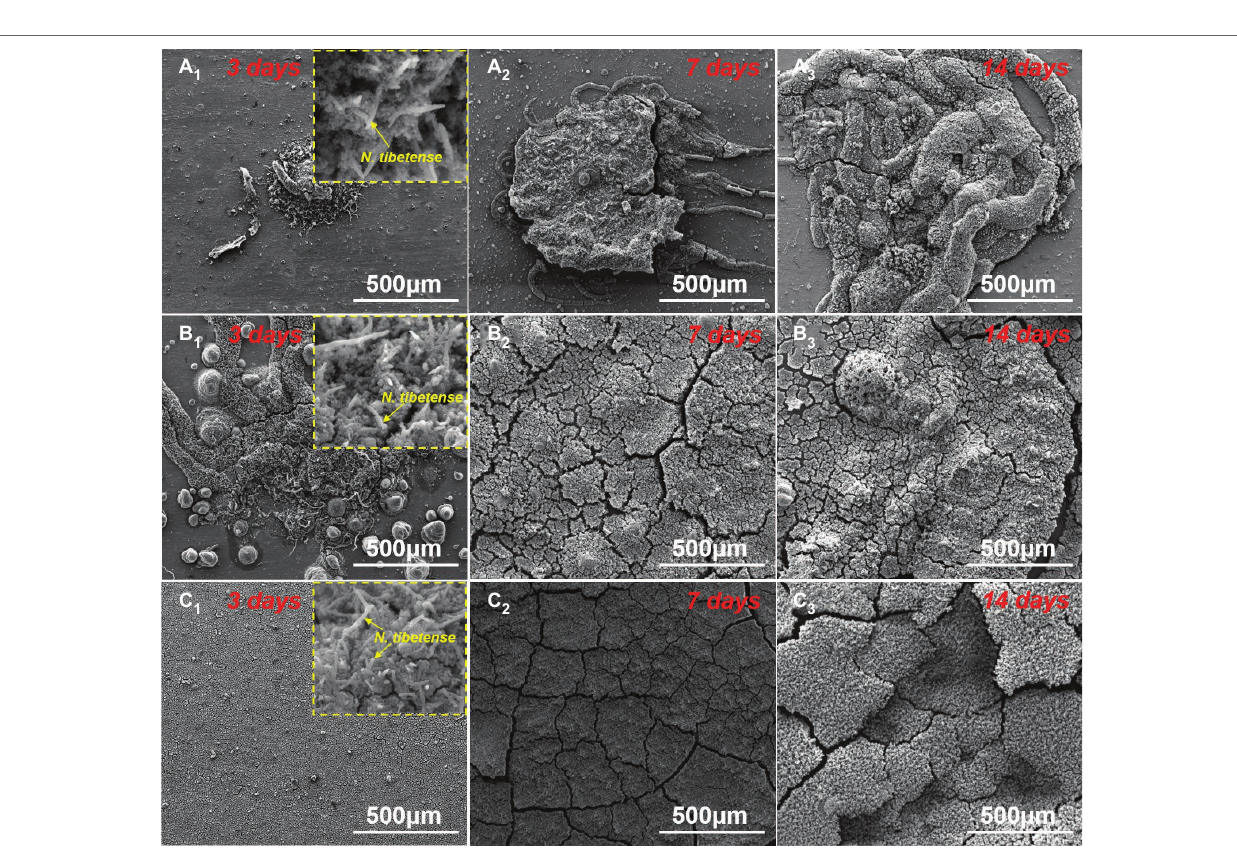
FIGURE 3 | SEM images of the corrosion products on sample surfaces after 3 (A 1 –C 1 ) , 7 (A 2 –C 2 ) , and 14 days (A 3 –C 3 ) of immersion in (A) 0.5 ppm, (B) 3.0 ppm, and (C) 5.0 ppm inoculated media. The insets are the morphologies of N. tibetense cells in corrosion products after 3 days.